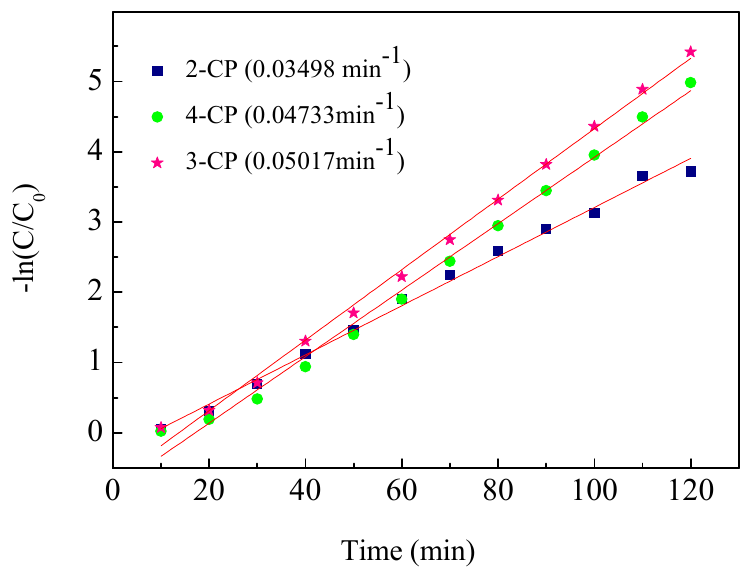
Figure 7. Kinetics during the ECH of 0.5 mmol L − 1 CP isomers.